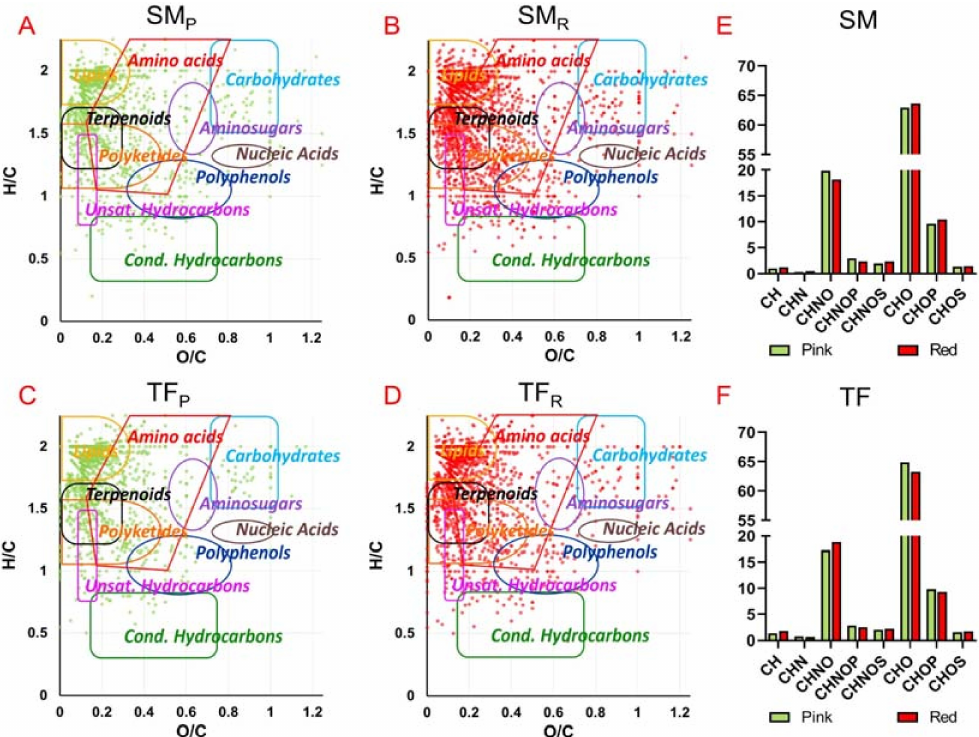
Figure 1. Van Krevelen plot (elemental plot) obtained from the molecular formulas obtained by ESI FT-ICR MS analysis of total hydroalcoholic and organic fractions of: ( A ) SM P ; ( B ) SM R ; ( C ) TF P ; ( D ) TF R . Histograms of the relative frequency of CH, CHN, CHNO, CHNOP, CHNOS, CHO, CHOP, CHOS compounds: ( E ) in SM P (green), SM R (red); ( F ) TF P (green) and TF R